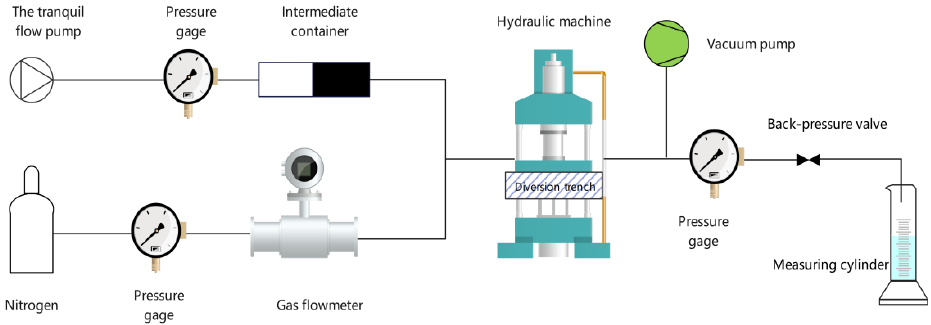
Figure 2. The schematic diagram of the long-term conductivity test system.